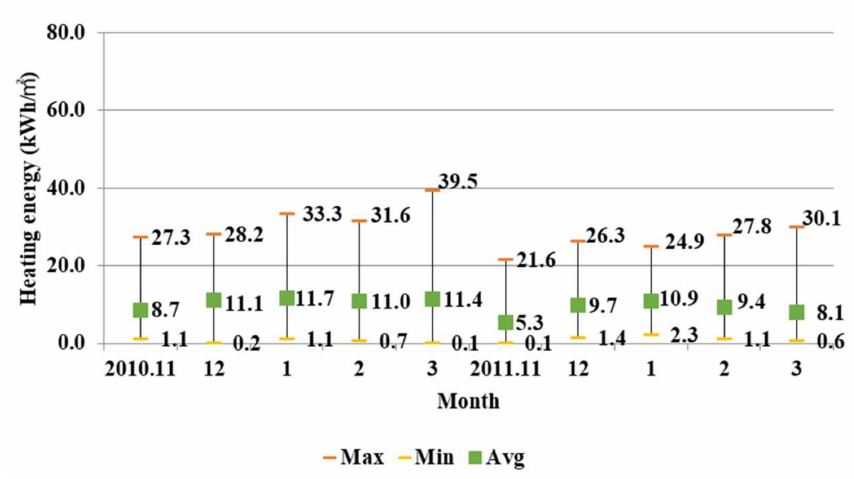
Figure 7. Maximum and minimum values of monthly heating energy from households sized 84 m 2 .